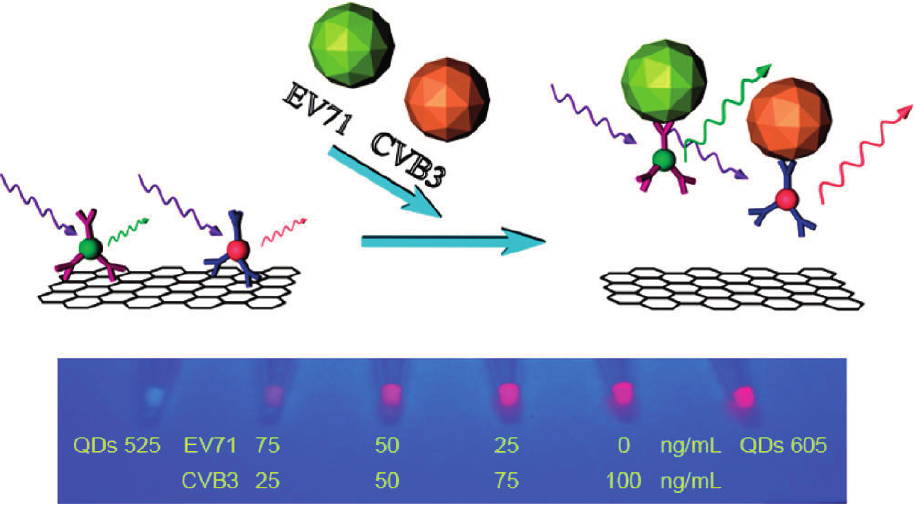
Figure 3. Schematic Presentation of the Multicolored QDs-Ab and GO Based EV71 and CVB3 Determination Biosensor and photovisualization of semiquatitative simultaneous determination of EV71 and CVB3 [105]. Reprinted with permission from (Chen, L.; Zhang, X.; Zhou, G.; Xiang, X.; Ji, X.; Zheng, Z.; He, Z.; Wang, H. Simultaneous determination of human enterovirus 71 and coxsackievirus b3 by dual-color quantum dots and homogeneous immunoassay. Anal. Chem. 2012 , 84 , 3200–3207.). Copyright